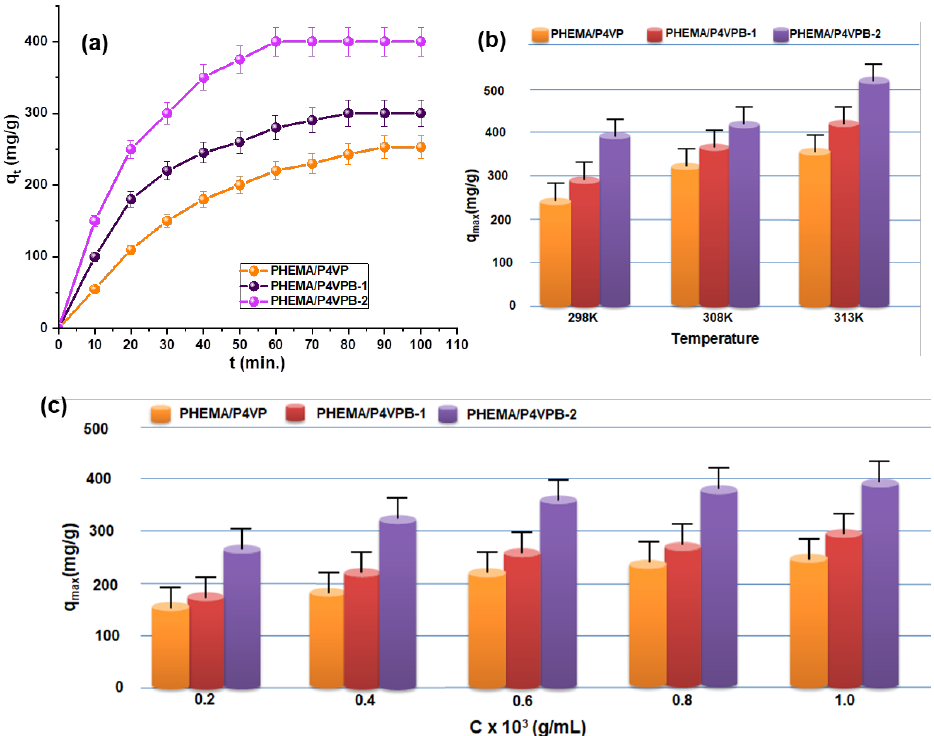
Figure 12. The influence of sorption parameters on the sorption capacity of semi-IPNs: ( a ) contact time (C tetracycline = 1 mg/mL, T = 298 K); ( b ) temperature (C tetracycline = 1 mg/mL, T = 298 K); ( c ) concentration of tetracycline solution (T = 298 K).